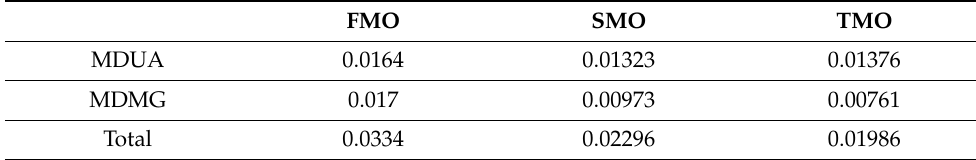
Table 7. Calculated items for the first approach. FMO SMO TMO MDUA